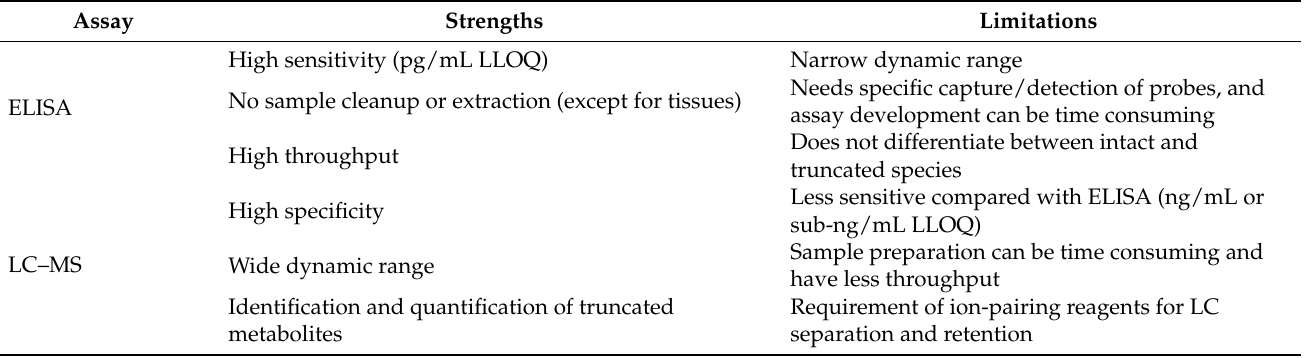
Table 2. Strengths and limitations of ELISA and LC–MS for the bioanalysis of